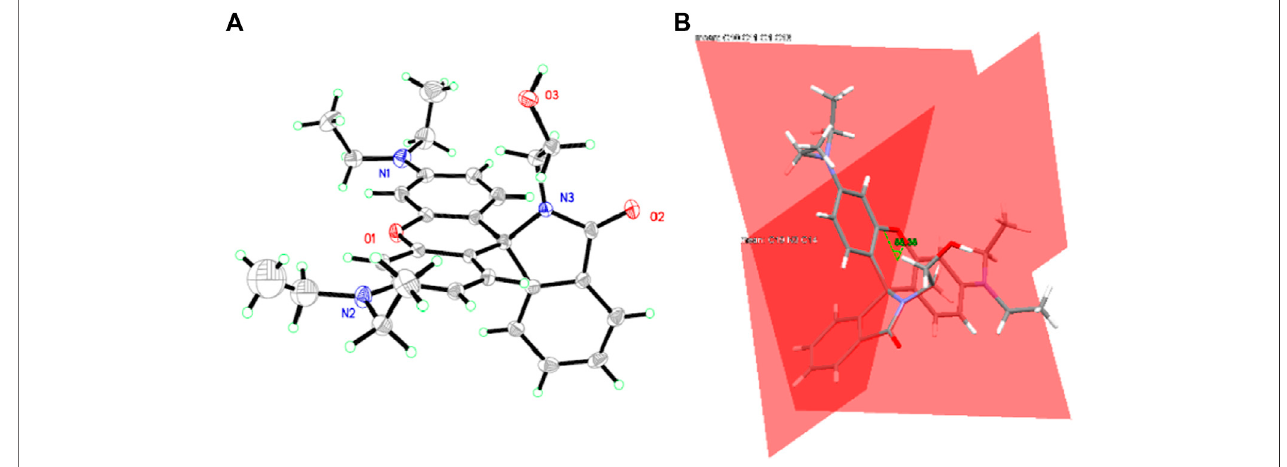
FIGURE2| Absorptionspectraofchemosensors(10 μ M)withtheadditionofFe 3+ (0.0 – 6.0equiv)intheaqueous(containing5%ethanolasaco-solvent), (A) CS1; (B) CS2; (C) , CS3; (D) , absorbance variation at 555 nm of these chemosensors.